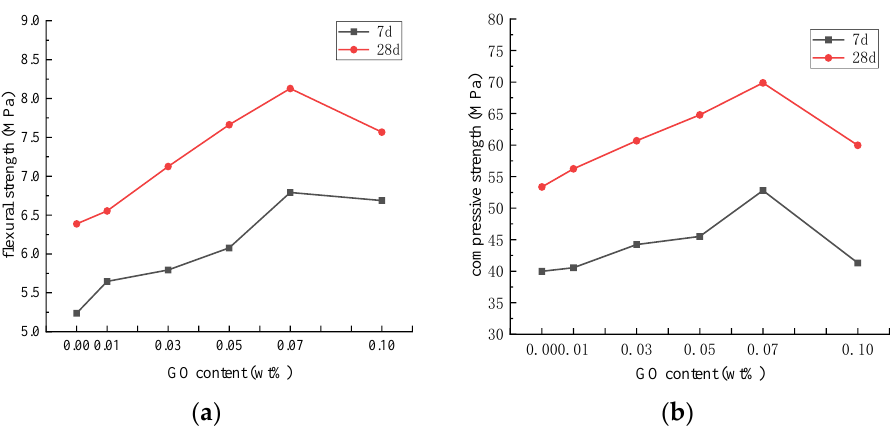
Figure 10. Effect of GO on mechanical properties of cement mortar. ( a ) Flexural strength, ( b ) com- pressive strength.